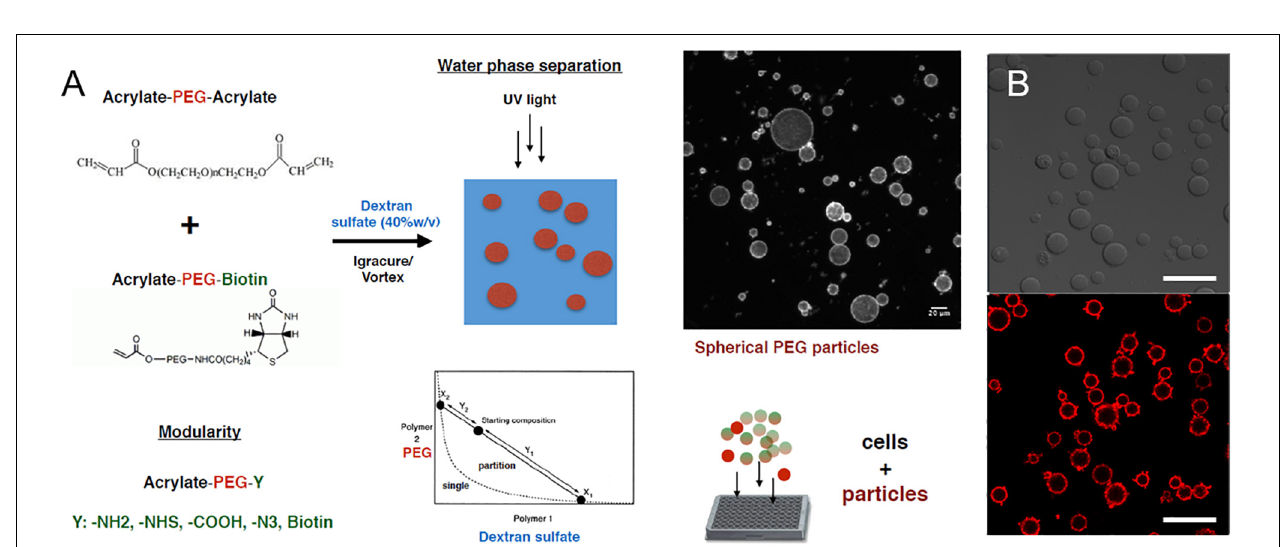
FIGURE 2 | PEG hydrogel microparticle fabrication. (A) Fabrication of PEG hydrogel microparticles via photopolymerization of Acrylate-PEG-Acrylate with Acrylate-PEG-Biotin. (B) 0.7% Biotin-PEG particles with surface conjugated streptavidin-Alexa Fluor 647 as a visual marker. Scale bar: 50 µ m.